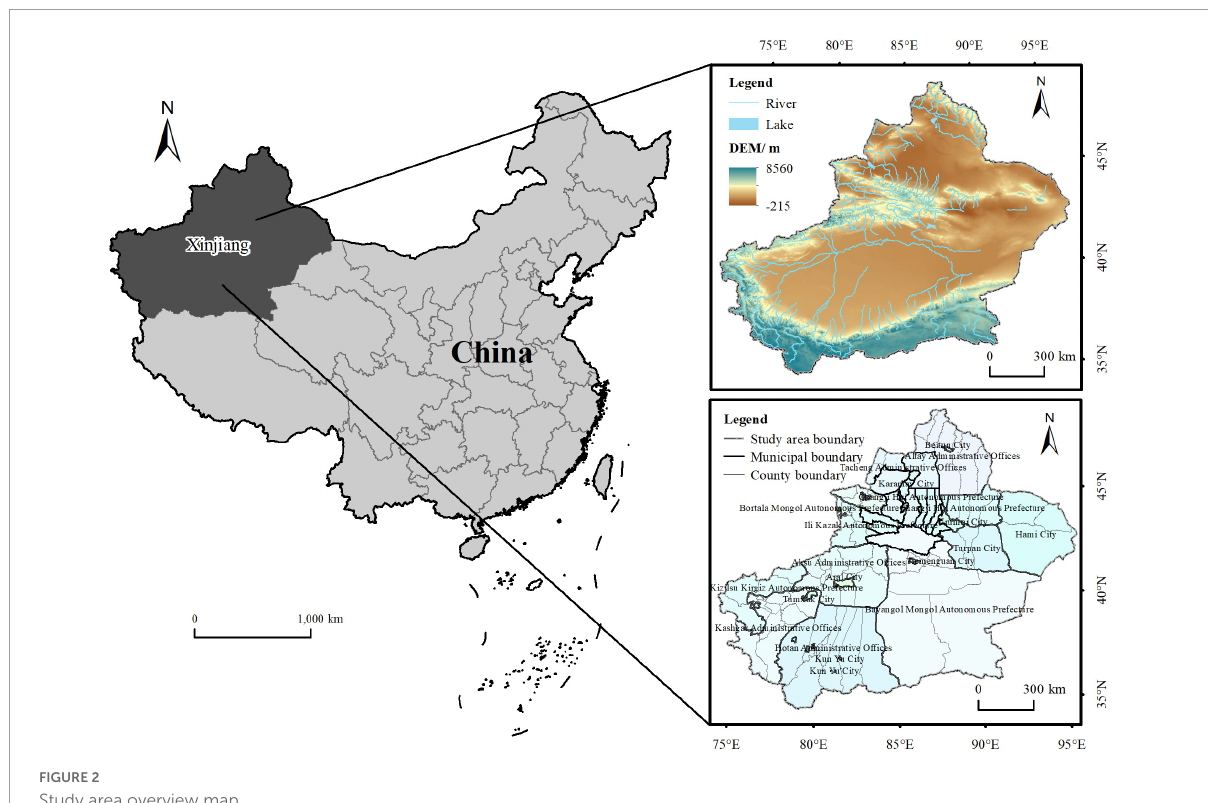
FIGURE2 Study area overview